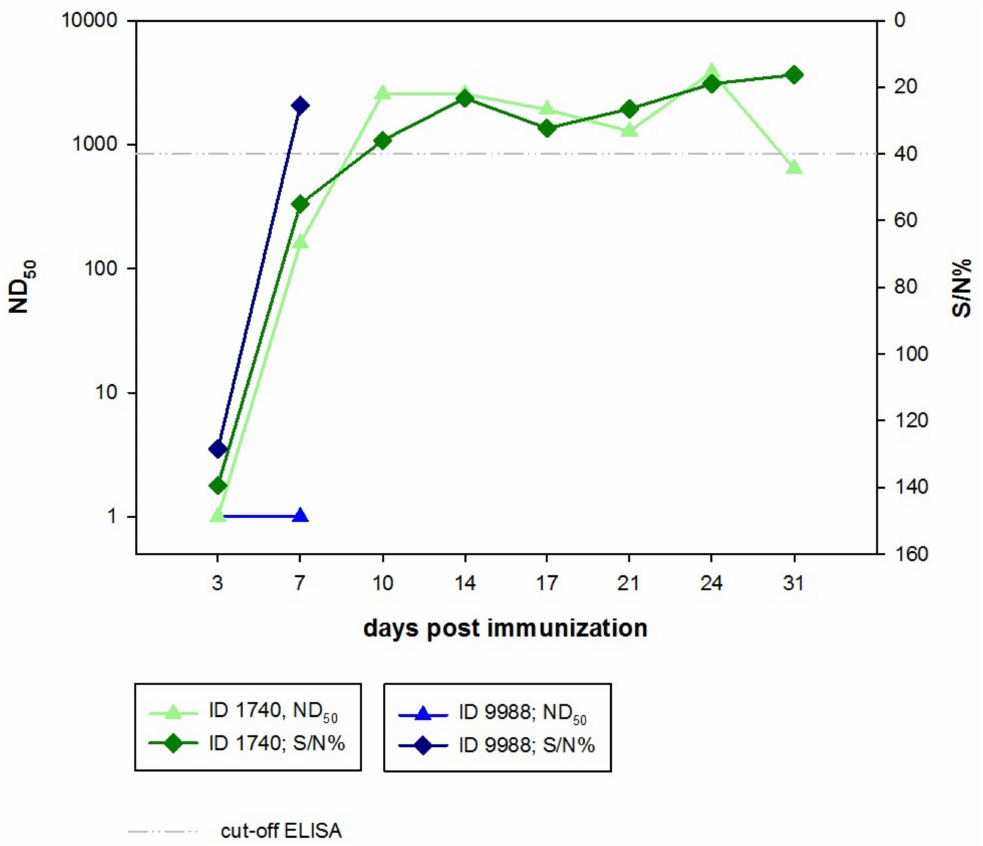
Figure 2. Serological reactivity of serum samples collected from ID 9988 sacrificed at 7 dpi, and ID 1740 sacrificed at 31 dpi. ND 50 : neutralizing doses of 50%; S/N%: percentage of